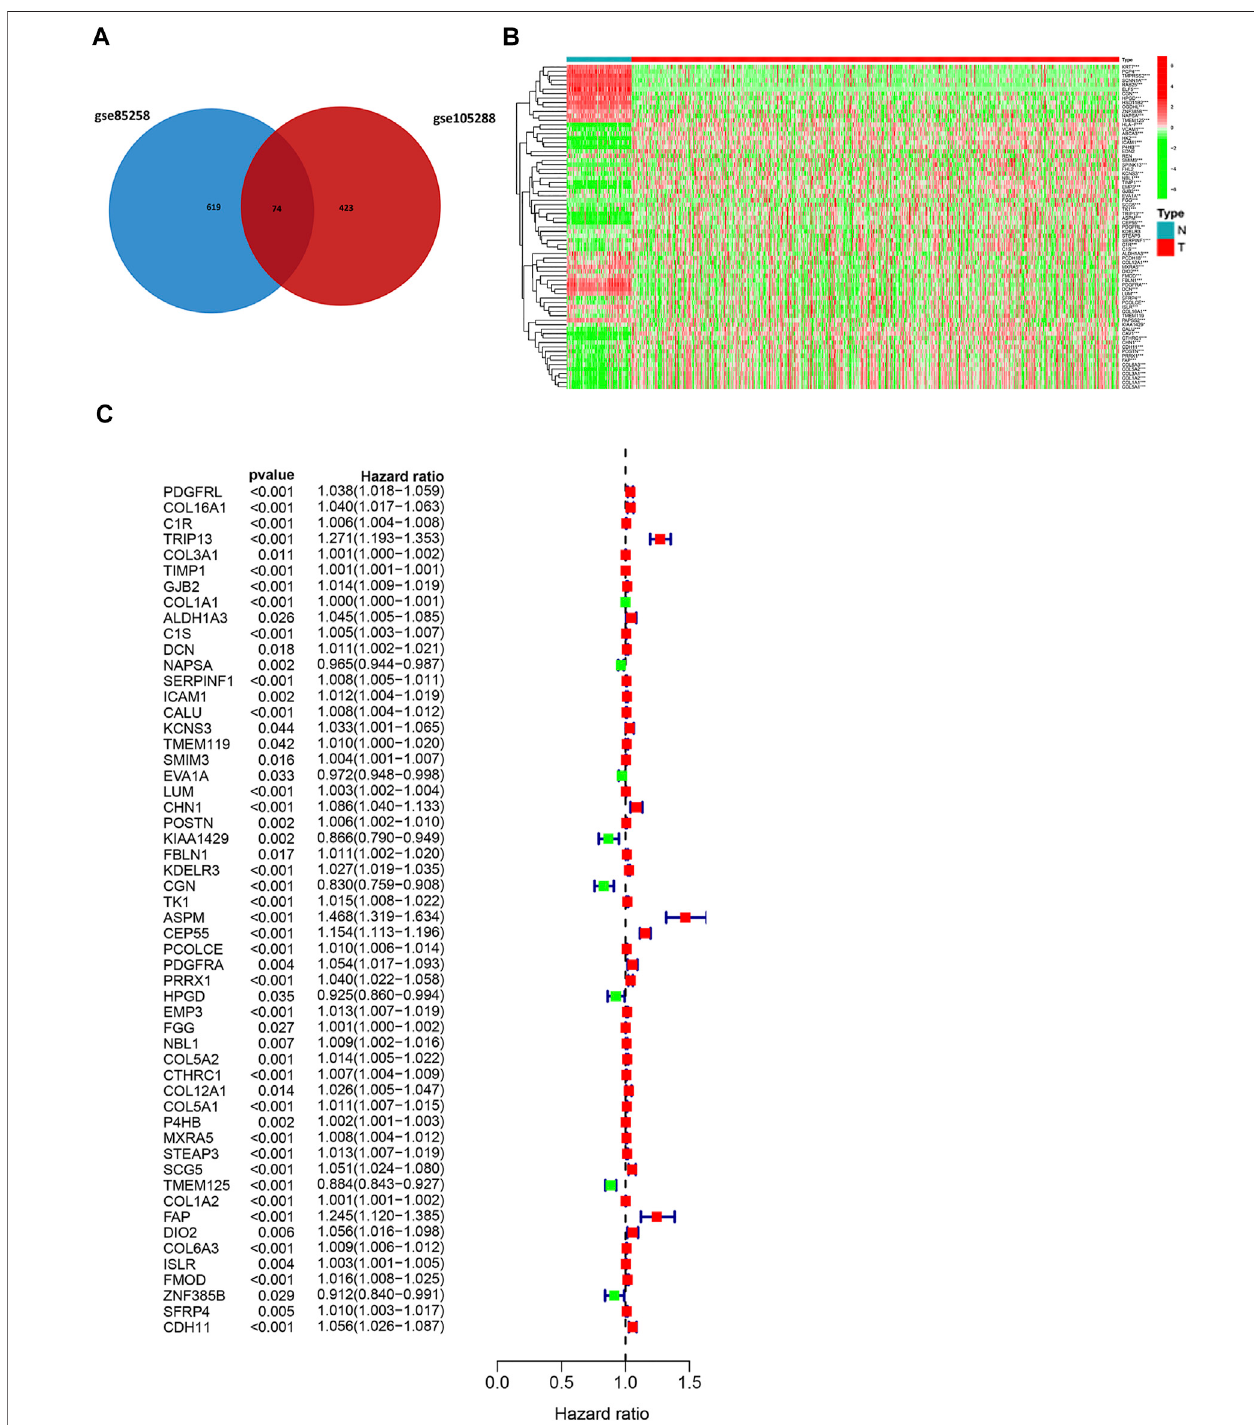
FIGURE 2 | Expression pro fi le of metastasis-associated genes in TCGA dataset. (A) Venn diagram of metastasis-associated DEGs. (B) Heatmap of metastasis- associated genes in TCGA ccRCC dataset. (C) Univariate Cox regression analysis.